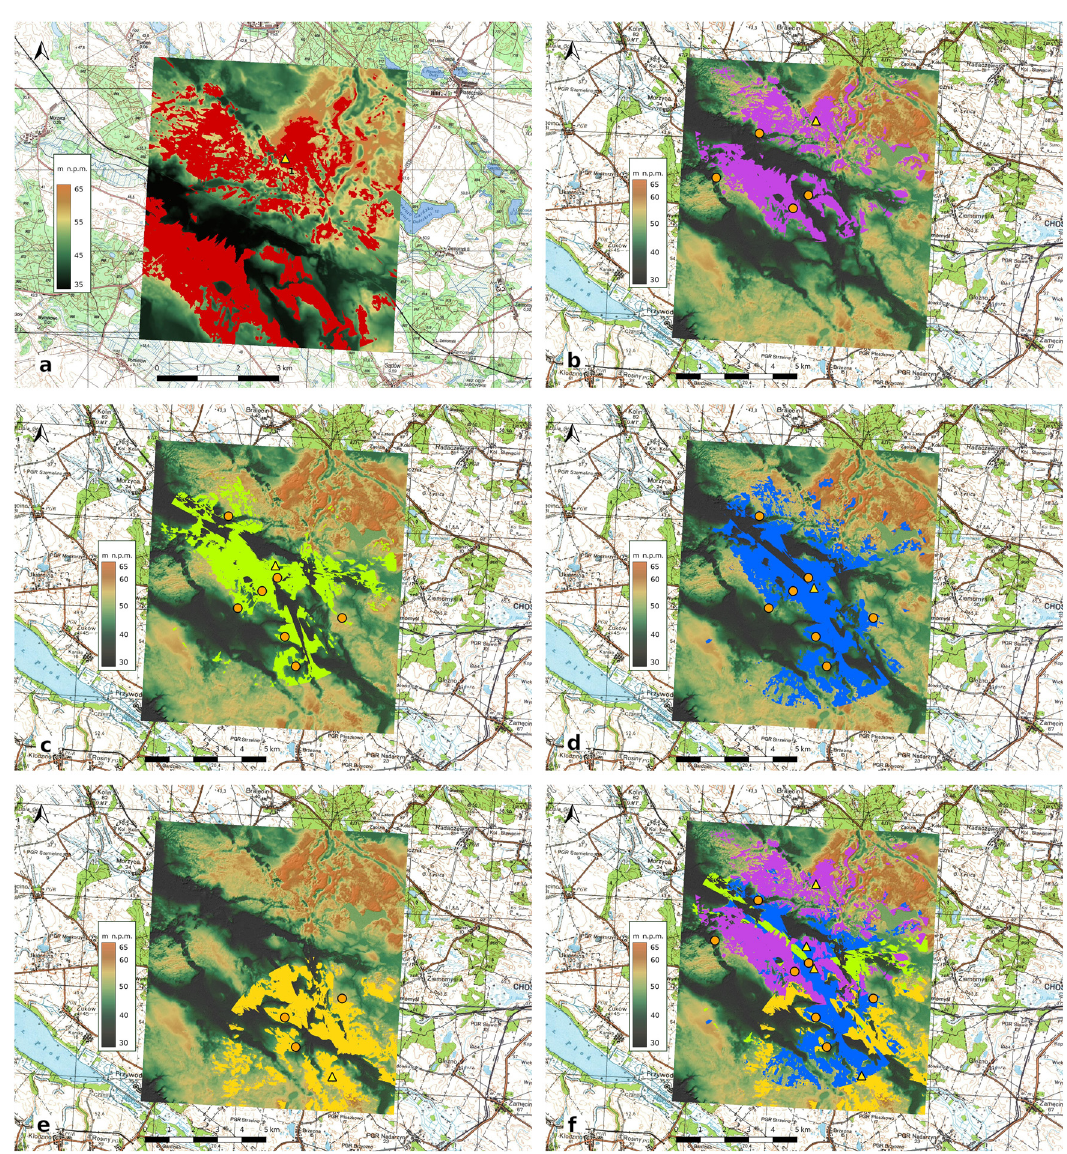
Figure 24: The visual relations between the Karsko tomb ( yellow triangle ) ( a ) , megalithic groups of Dolice - Rondo Lucjana ( b ) , Dolice - Komorowo North ( c ) , Dolice - Komorowo South ( d ) and P ł oszkowo ( e ) and the sites interpreted as FBC settlements ( orange dots ) within a radius of 5 km, as well as the visual relations between the Dolice megalithic group ( yellow triangle ) and the sites interpreted as FBC settlements ( orange dots ) within a radius of 5 km ( f ) ( M. Schiller )